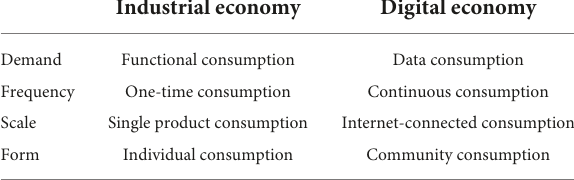
TABLE 1 Consumption characteristics under different economic models.